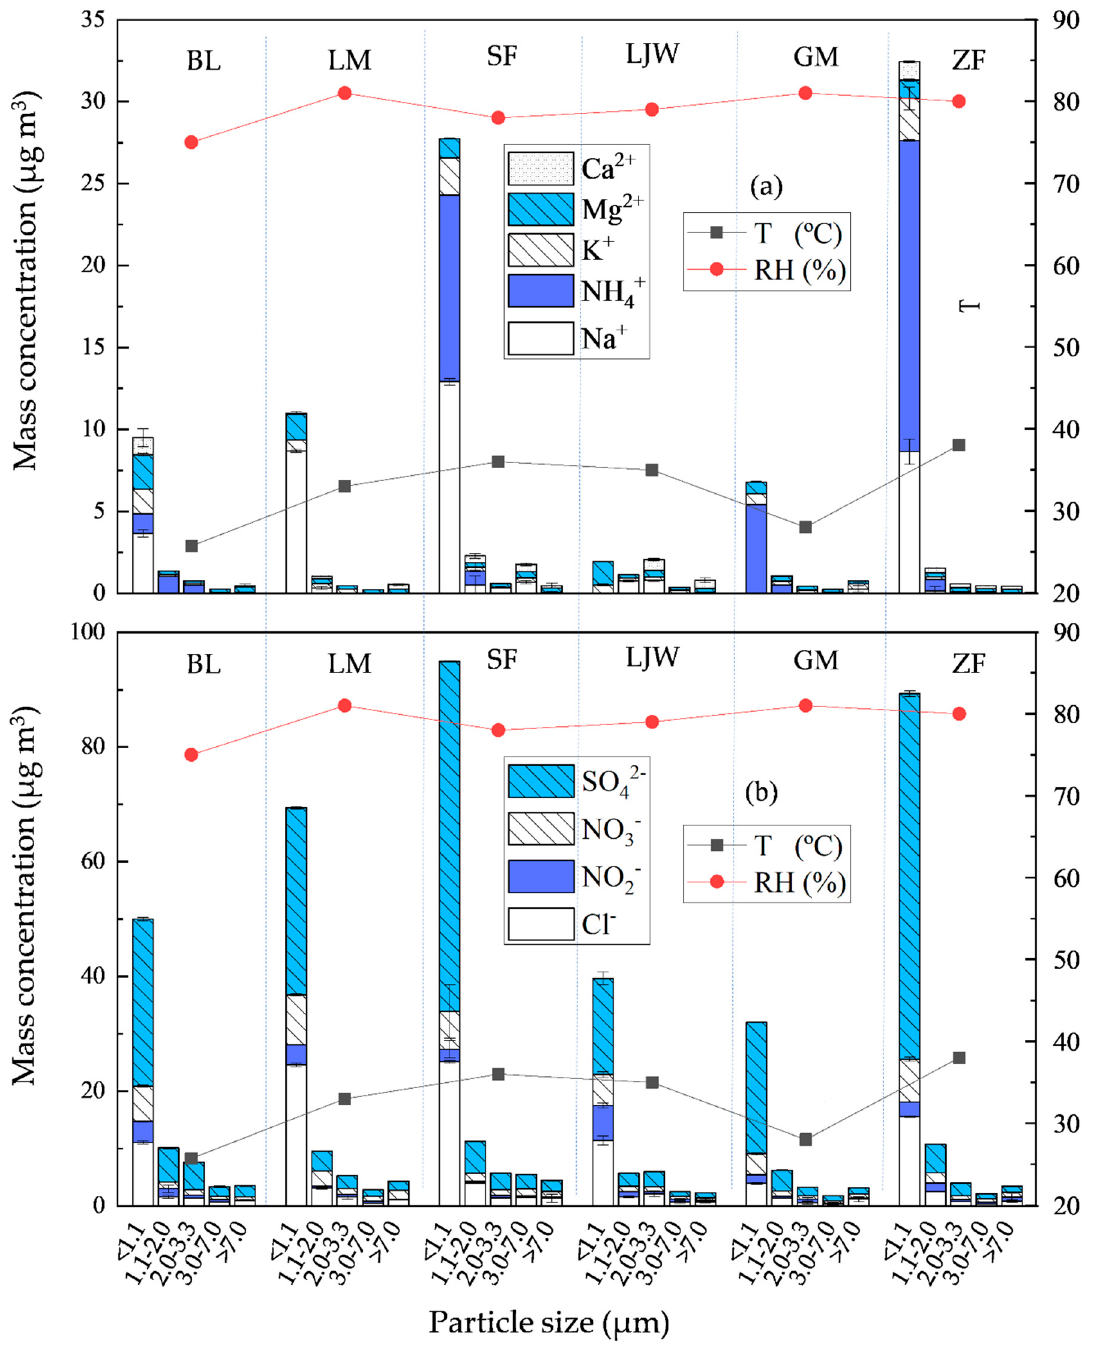
Figure 6. Mass concentration ( µ g m − 3 ) and standard deviation (STD) of ion species (Coal, N = 6, ( a ): cation mass concentration; ( b ): anion mass concentrations) (Bole coal (BL), Luomu coal (LM), Shunfa coal (SF), Lijiawu coal (LJW), Guangming coal (GM), and Zongfan coal (ZF)).